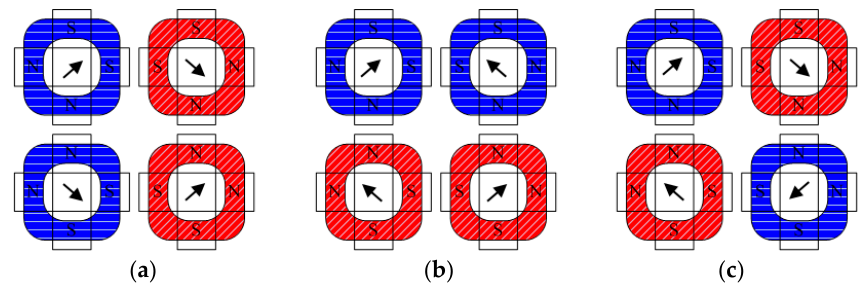
Figure 3. Working principle of the Lorentz ‐ force ‐ driven planar motor: ( a ) Moving in the x axis; ( b ) Moving in the y axis; ( c ) Rotating about the z axis.